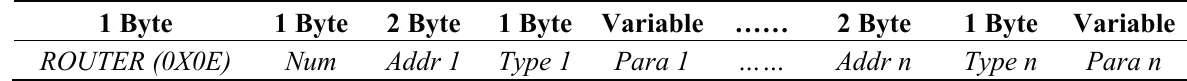
Table 3. Frame format on routing node.